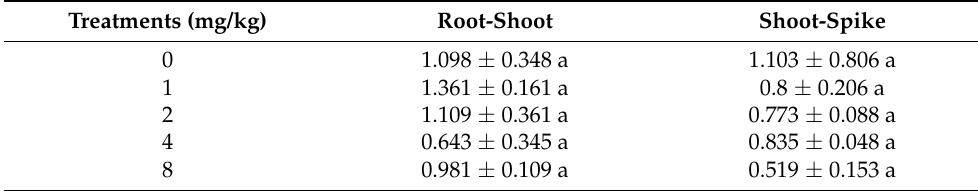
Table 1. Cd transport coefficients of sea